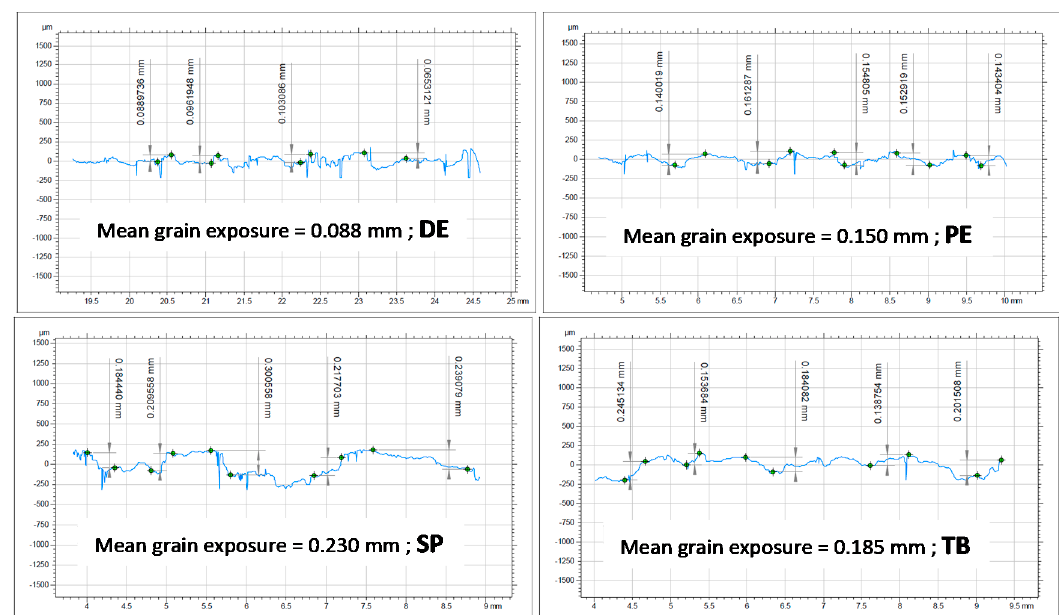
Figure 6. Measurement of the average grain height of worn discs.